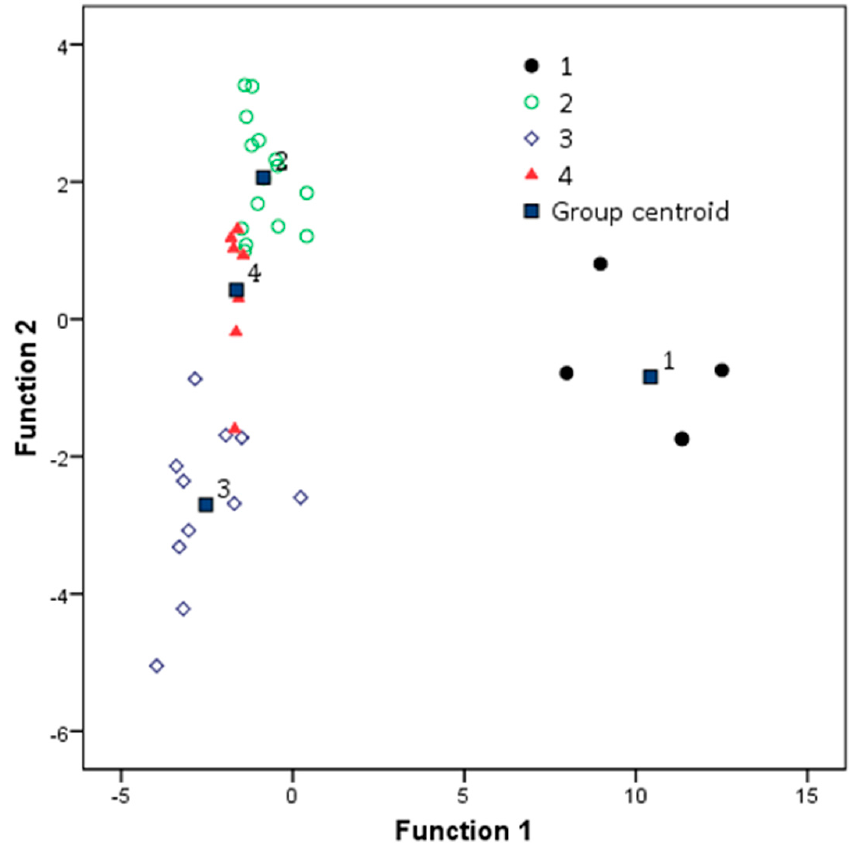
Figure 4. Canonical discriminant functions for the water quality variables in China’s Xiujiang River.